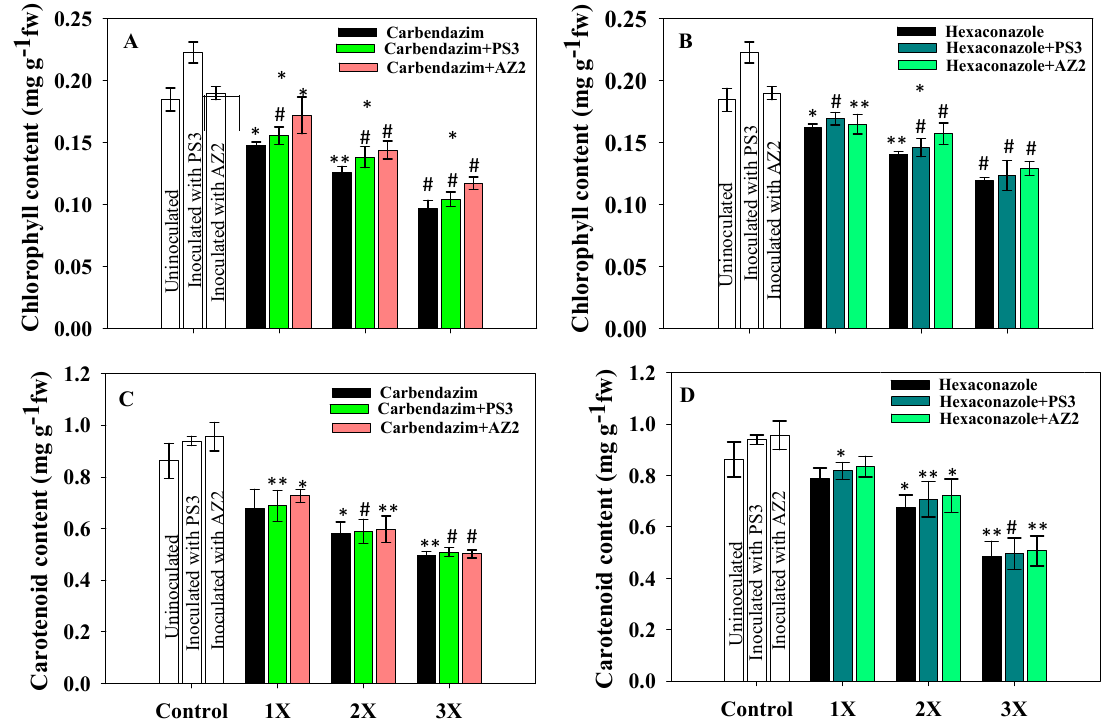
Figure 7. Effect of inoculation of Pseudomonas sp. PS3 and Pseudomonas sp. AZ2 on total chlorophyll content mg g − 1 fresh weight (fw) in foliage of R. sativus treated with varying concentrations of carbendazim ( A ) and hexaconazole ( B ). Panels ( C , D ) represent the impact of Pseudomonas sp. PS3 and Pseudomonas sp. AZ2 on carotenoid content extracted from radish foliage. In this figure, histograms represent the mean value of three independent replicates ( n = 3) and error bars represent S.D. The asterisks *, ** and # denote statistical significance at p < 0.05, p < 0.005 and p < 0.001, respectively computed by Student’s t -test. 1X, 2X and 3X denote the normal, two times and three times greater concentrations of fungicide.